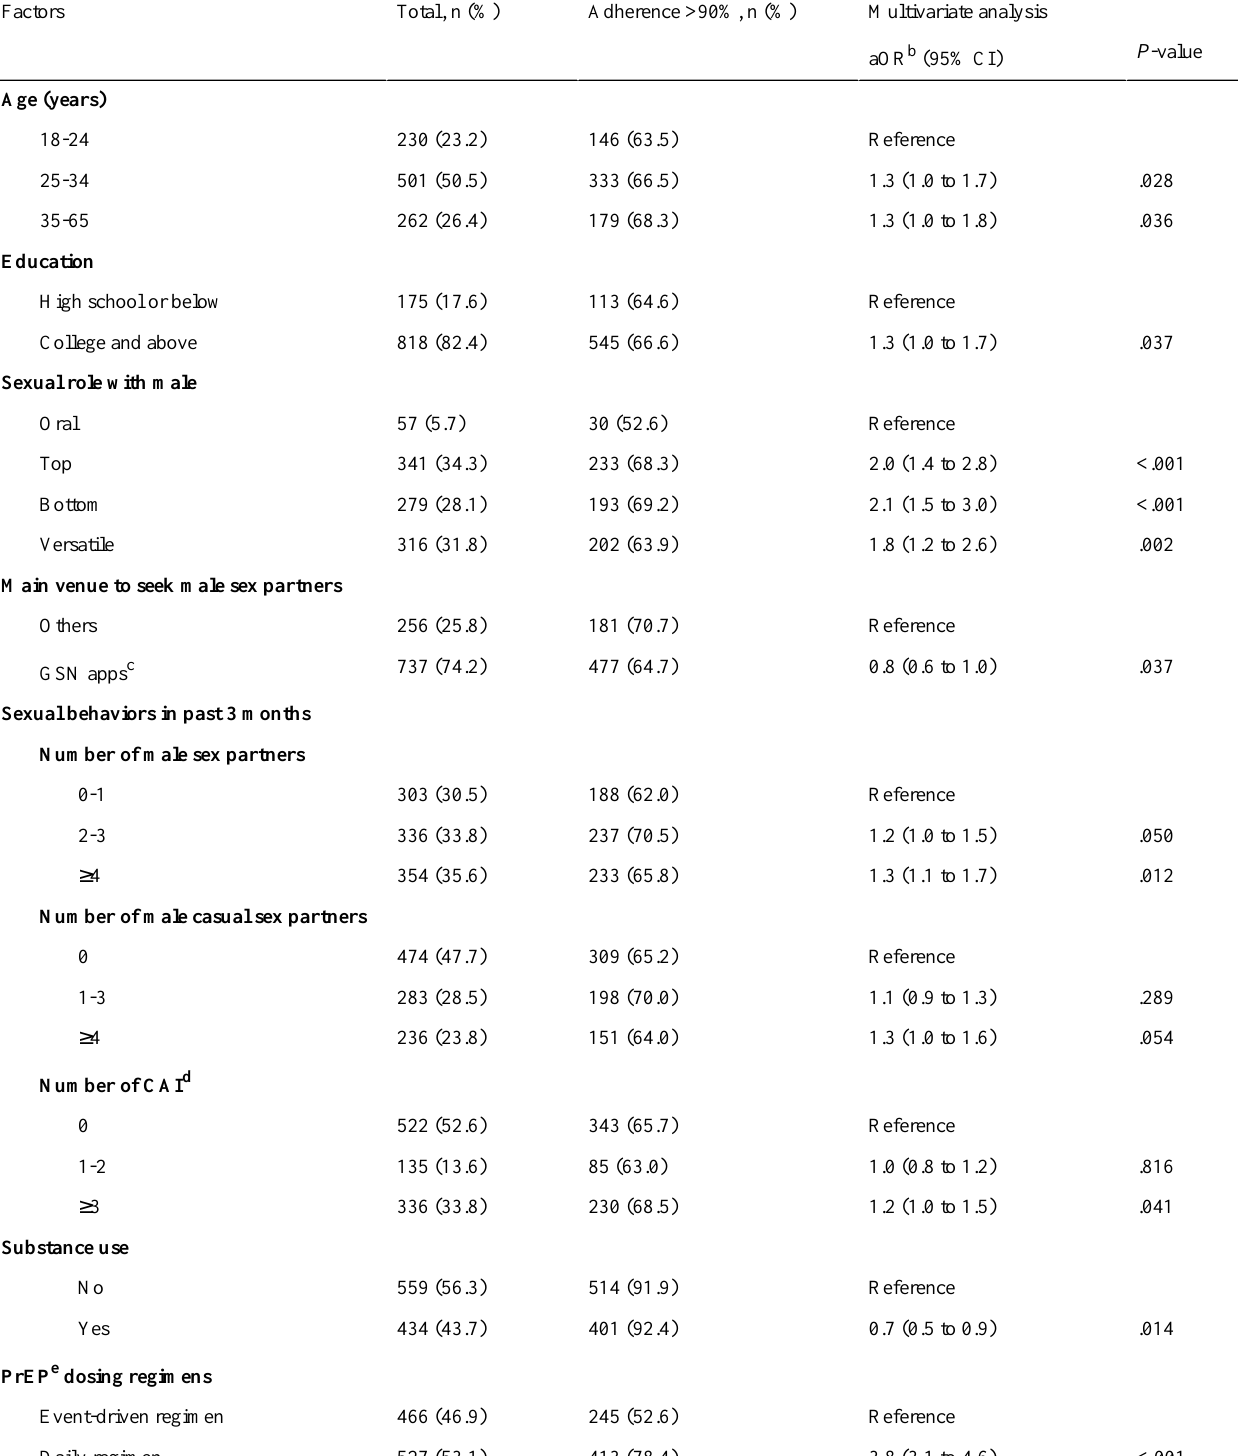
Table 2. Generalized estimated equation analysis of behaviors during follow-up as predictors of over 90% adherence to pre-exposure prophylaxis by pill counting (N=993).